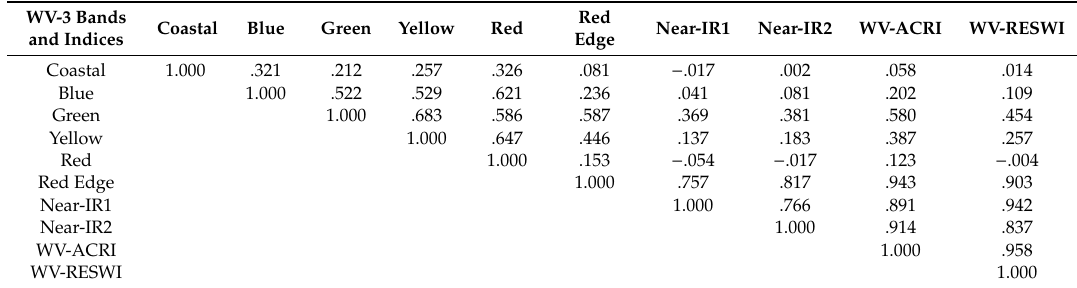
Table 5. Correlation matrix of the variables from Table